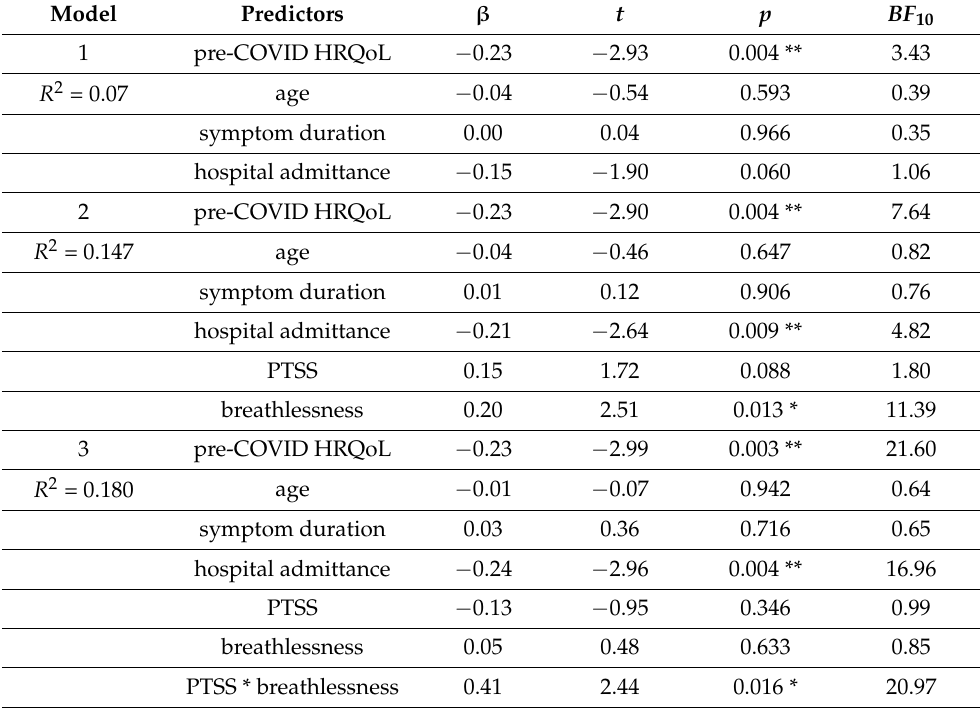
Table 1. Summary of hierarchical multiple regression analyses for predictors of fatigue in PCS.